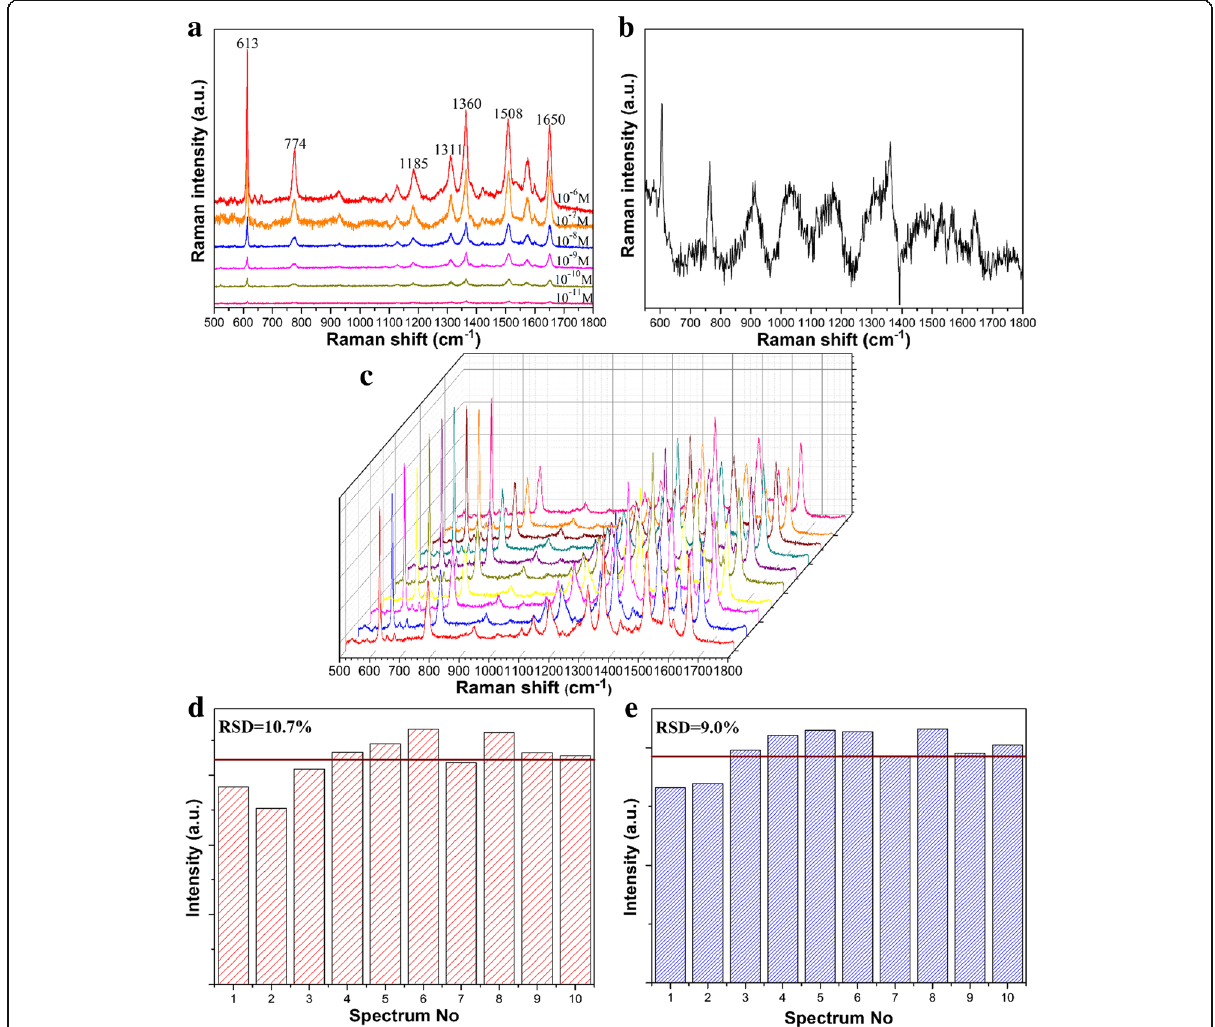
Fig. 6 a Raman spectra of Rh6G on the GNR vertical array substrate from 10 − 6 to 10 − 11 M, respectively. b The Raman spectrum of 10 − 3 M Rh6G on silicon substrate. c Raman spectra of Rh6G with a concentration of 10 − 7 M. d , e Intensity distribution of the peaks at 1360 cm − 1 and 774 cm − 1 for the Rh6G with a concentration of 10 − 7 M from 10 different batches of GNR vertical array